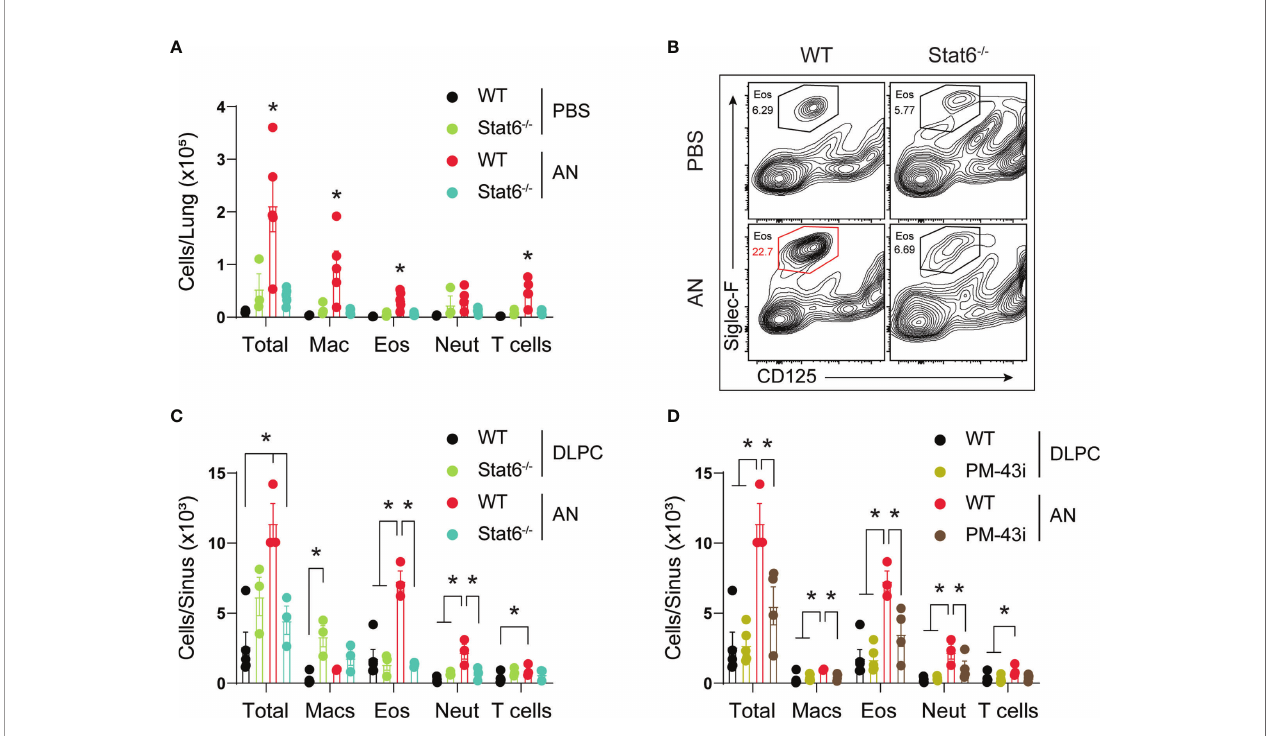
FIGURE 7 | STAT6 is essential for eosinophilic murine sinusitis. (A) Stat6-/- or C57BL/6 mice were challenged (i.n.) with 4 × 10 5 A. niger (AN) or PBS for 3 months and lungs were assessed for in fl ammatory cell recruitment. (B) Representative fl ow analysis of Siglec-F and CD125 expression in wildtype (Wt) and Stat6-/- mice challenged with fungus (AN) or vehicle (PBS/DLPC) and (C) quanti fi ed. (D) Sinus in fl ammatory cell analysis from fungal challenged mice treated with 10 ng of PM-43i or vehicle (PBS/DLPC). * p < 0.05, n ≥ 3 by ANOVA. Data are from one of three representative